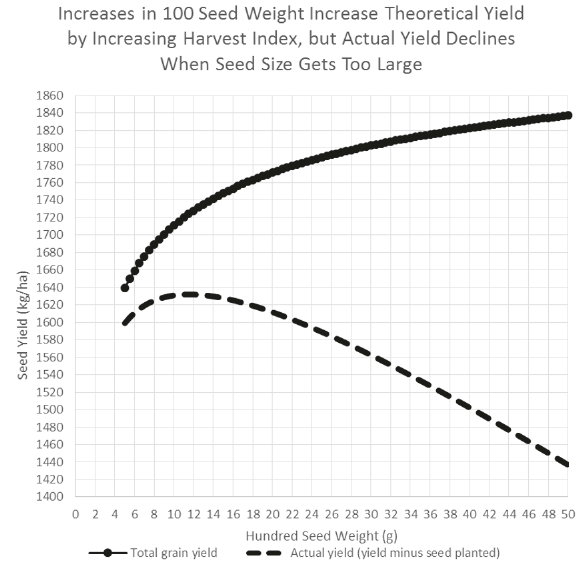
Figure 4: The contrast between the weight of the grain harvested and actual yield (grain harvested minus seed planted) as seed size